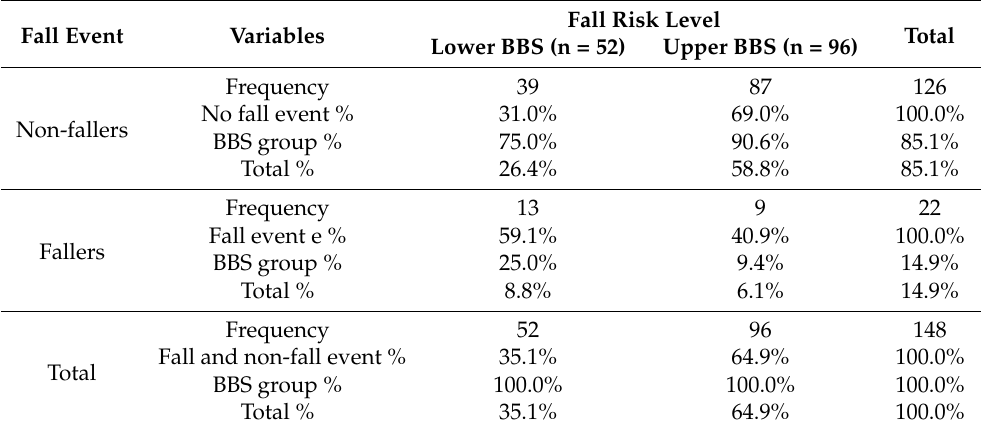
Table 2. Comparison of fall events according to fall risk level